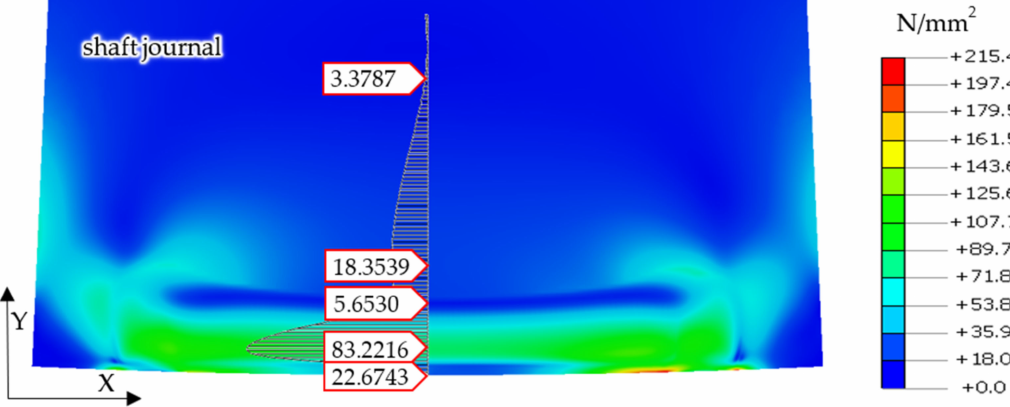
Figure 12. Distribution of permanent stress values in the surface layer of a steel shaft journal with a profile free of outline irregularities after the outline has been turned over a support roller made of